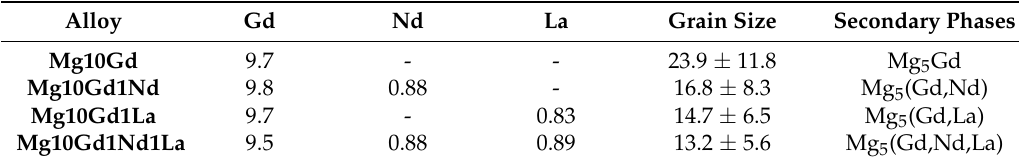
Table 2. Chemical composition in wt.%, grain sizes in µ m, and secondary phases in extruded alloys investigated